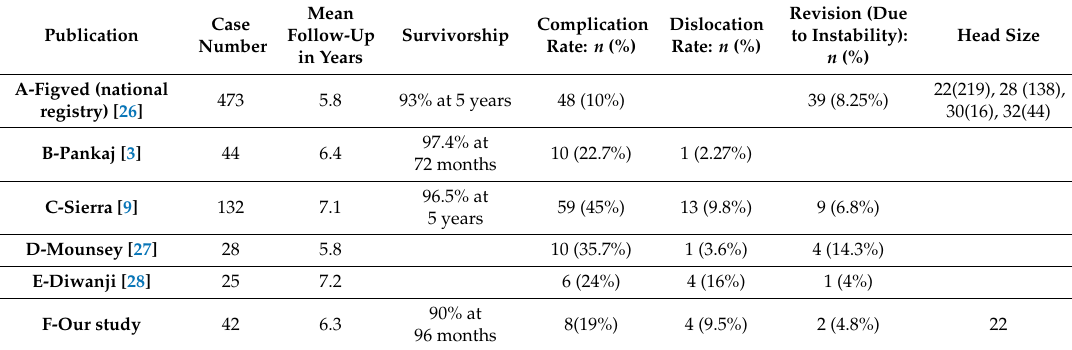
Table 7. Publications in the literature on revision of hemi-arthroplasty to total hip